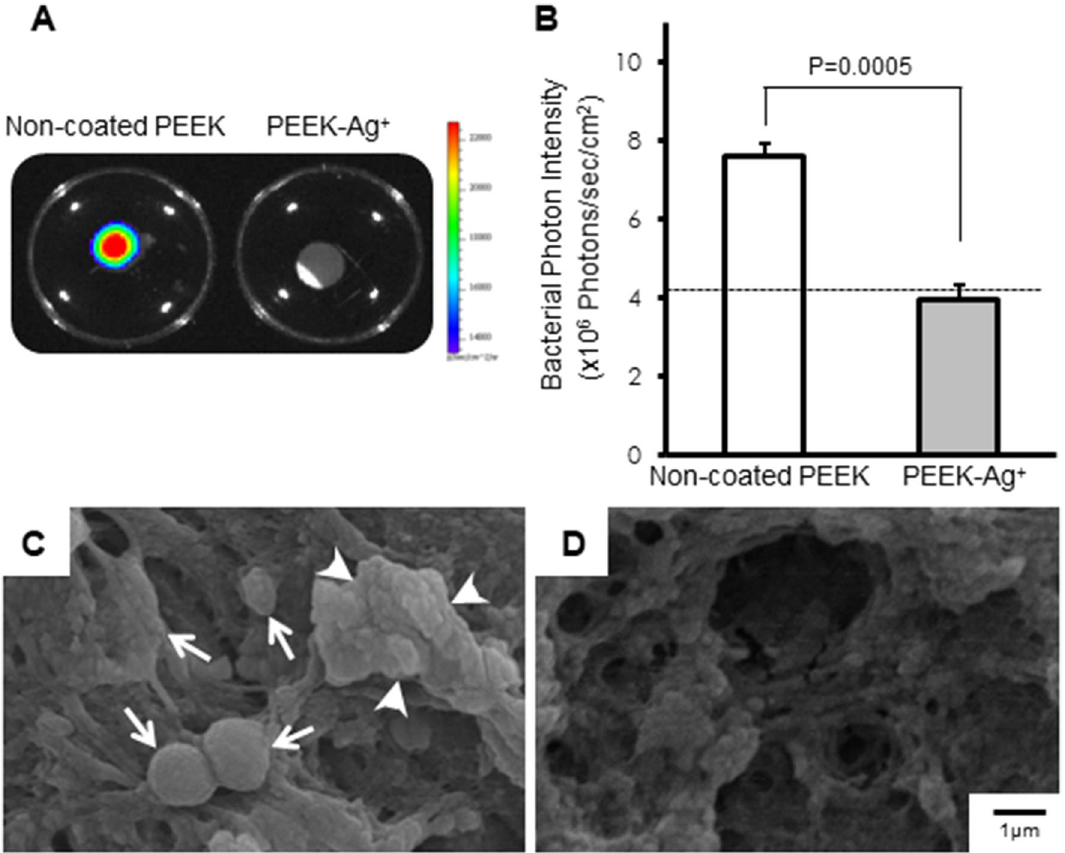
Figure 5. Optical and SEM images of PEEK plates removed from the infection mouse model. On Day 14, implanted PEEK plates were removed from the SGM and washed 3 times in phosphate buffered saline (PBS). The bacterial bioluminescent signals were then captured by BLI. A strong signal was observed on the surface of the non-coated PEEK, but not on the PEEK-Ag + ( A ). The signal on the non-coated PEEK was significantly greater than that on the PEEK-Ag + ( p = 0.0005) ( B ). The microstructures of the surface of these PEEKs